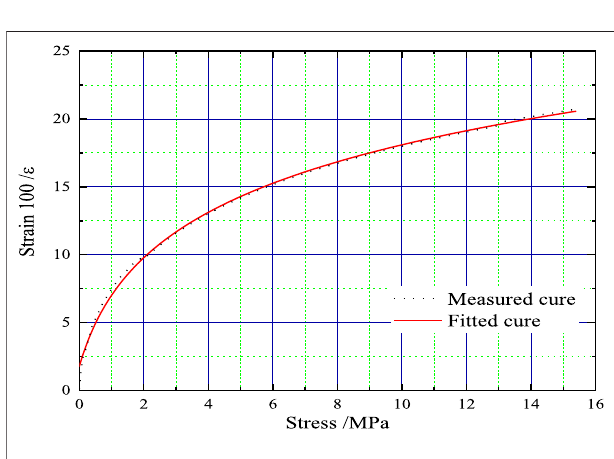
FIGURE 9 | Measured and fi tted stress – strain curves (mixed- fi lling gangue).